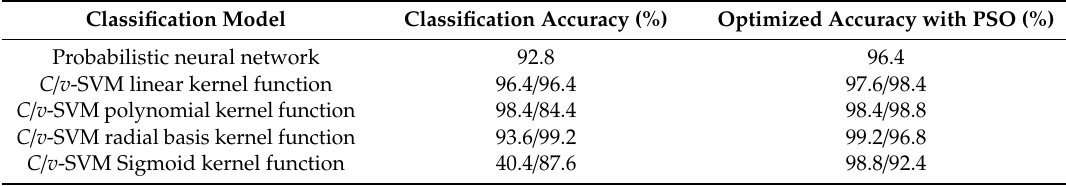
Table 4. Comparison of PNN / SVM classification